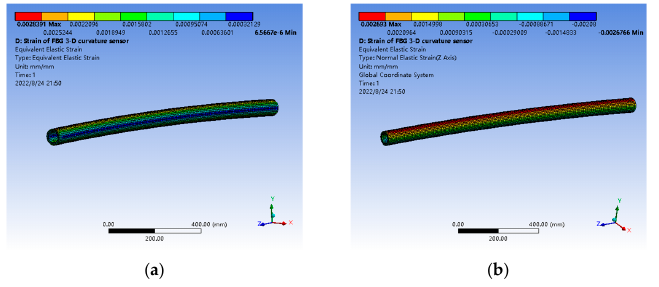
Figure 5. Nephogram of equivalent strain and Z-direction elastic strain of FBG curvature sensor when the curvature radius is 15,000 mm. ( a ) Equivalent strain; ( b ) Z-direction elastic strain. Figure 6 shows the strain distribution nephogram of FBG under different rotation error angles after the FBG curvature sensor with an orthogonal arrangement bends with a curvature radius of 15,000 mm along the negative direction of the Y-axis. It can be seen from the figure that under the influence of the rotation error angle, the FBG strain of the orthogonal arrangement will produce errors compared with the FBG strain when the ro- tation error angle is zero. Secondly, as the rotation error angle gradually increases from 0° to 90°, the strain of FBG I in the two grating strings arranged orthogonally will gradually decrease, and the strain of FBG II will gradually increase.